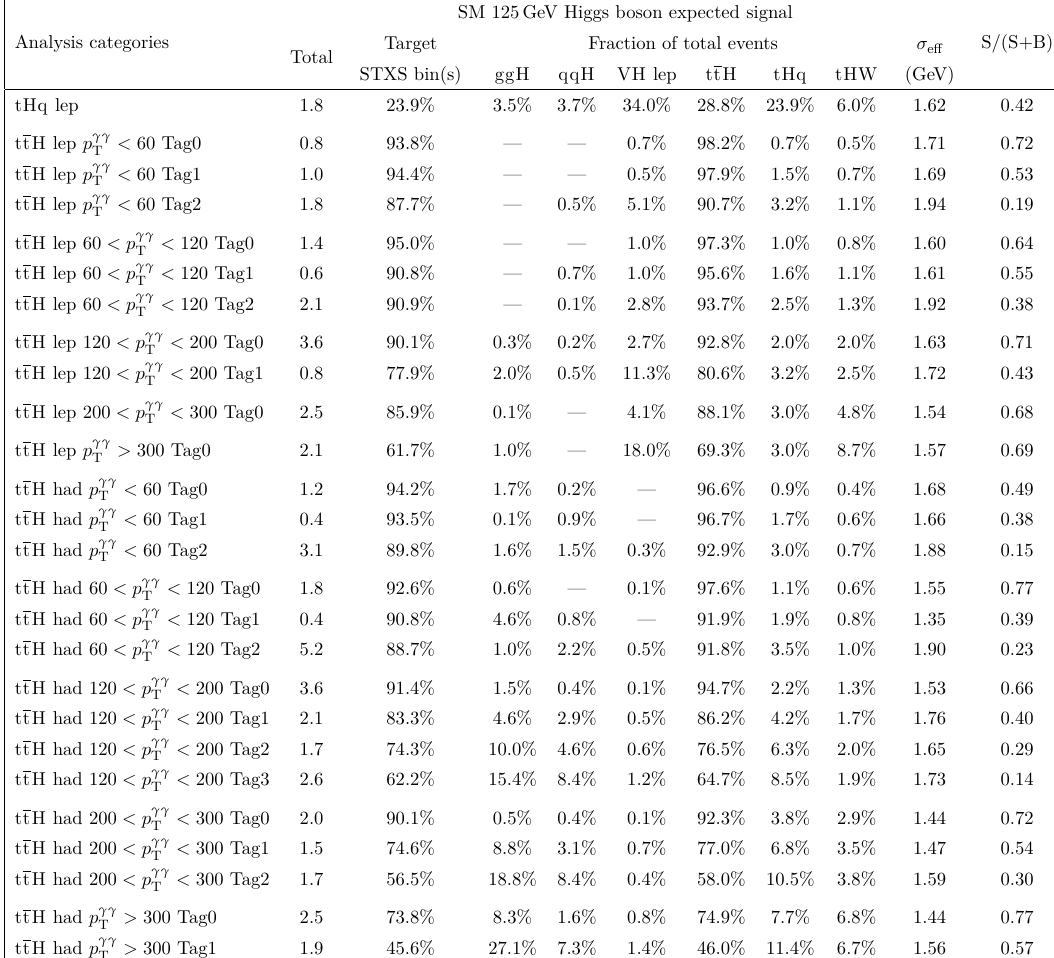
= 125 GeV in analysis categories target- Table 9 . The expected number of signal events for m H ing Higgs boson production in association with top quark, shown for an integrated luminosity of 137 fb − 1 . The fraction of the total number of events arising from each production mode in each analysis category is provided, as is the fraction of events originating from the targeted STXS bin or bins. Entries with values less than 0.05% are not shown. Here ggH includes contributions from the ggZ(qq)H and bbH production modes, whilst qqH incorporates both VBF and hadronic VH production. The σ , defined as the smallest interval containing 68.3% of the m distribution, is eff gg listed for each analysis category. The final column shows the expected ratio of signal to signal-plus- background, S/(S+B), where S and B are the numbers of expected signal and background events in a ± 1 σ window centred on m eff H